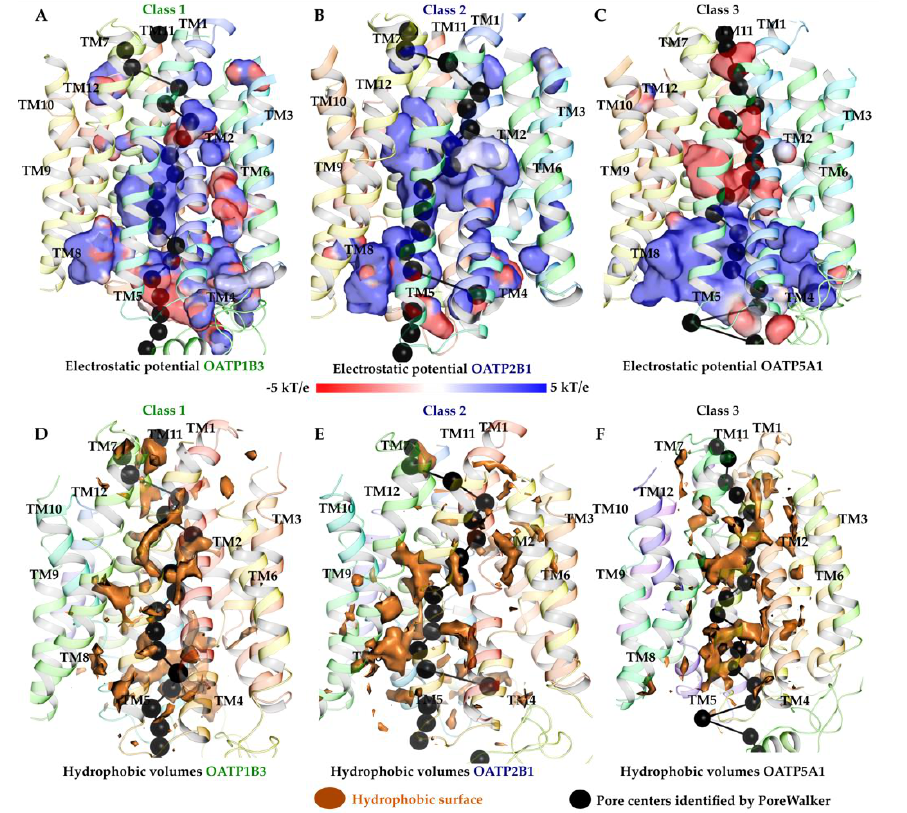
Figure 4. Electrostatic potential surfaces ( A – C ) and hydrophobic volumes ( D – F ) shown along the pore. ( A ) Electrostatic potential surfaces of class 1 (OATP1B3). ( B ) Electrostatic potential surfaces of class 2 (OATP2B1). ( C ) Electrostatic potential surfaces of class 3 (OATP5A1). Positive potentials shown in blue, negative in red, neutral in white and hydrophobic surfaces in orange.